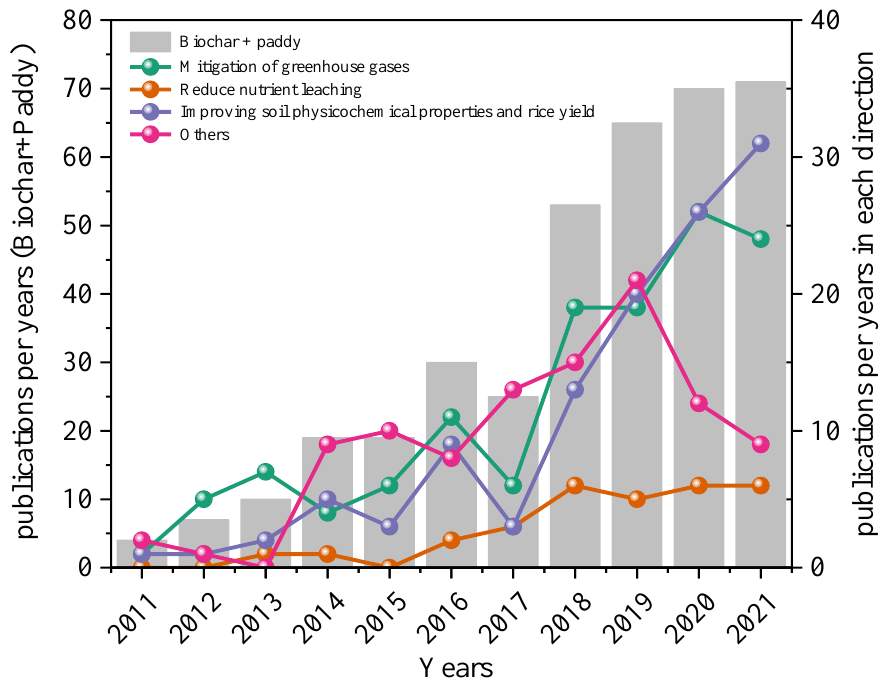
Figure 1. Publications per year on BC application in paddy fields (2011 – 2021).